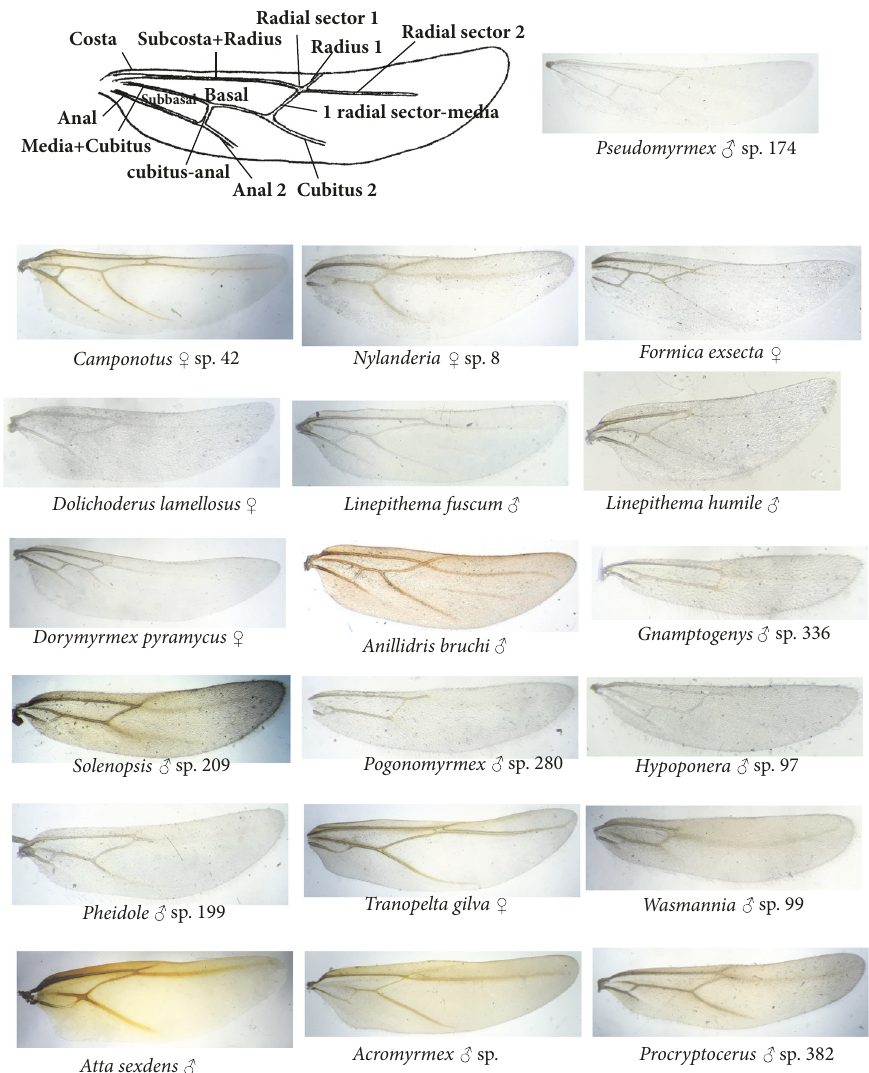
Figure 2: Hindwing of Typology II with Cells and Veins terminology. The photos represent some examples of hindwings of Typology II; the dimensions are not comparable (photos by personal Cantone collection of Winged